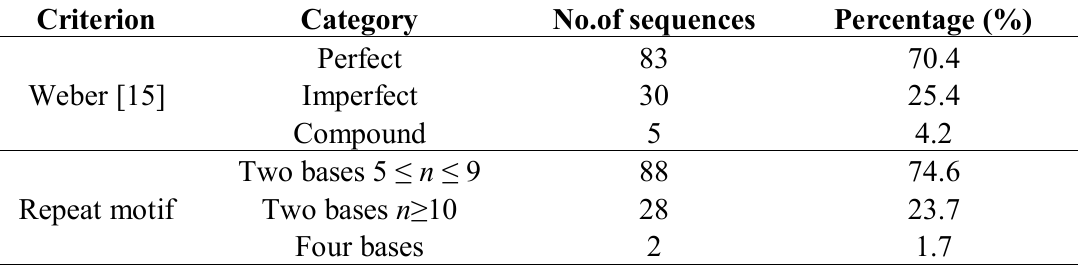
Table1. Classification of microsatellite DNA sequences obtained in this